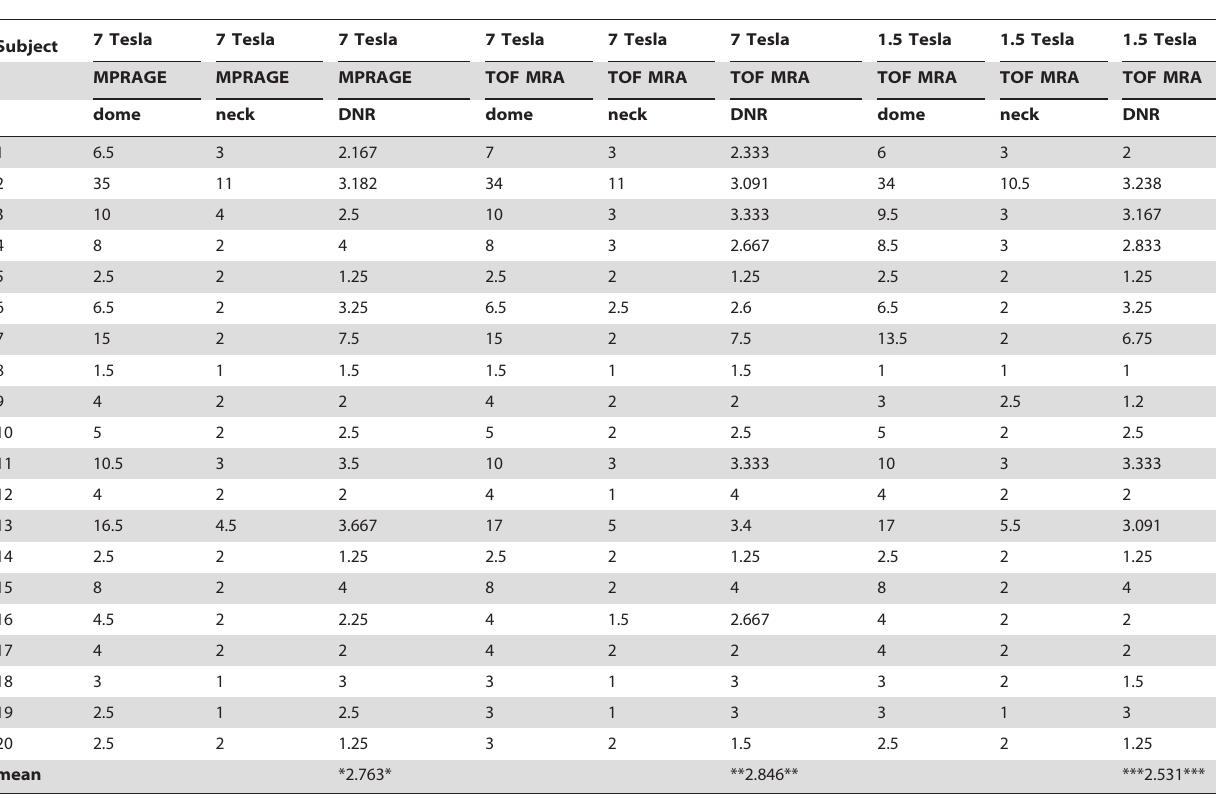
Table 4. Combined readings of both raters for dome and neck diameter in mm and dome/neck ratio (DNR) for all